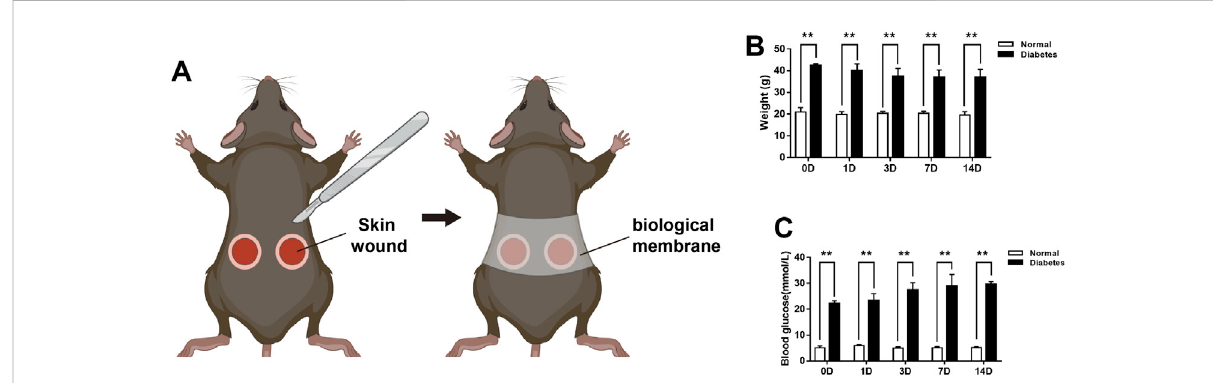
FIGURE 1 The experimental mice model and body weights and blood glucose levels of mice during wound healing (A) The wound healing model. Measurement of the mice body weights (B) and blood glucose levels (C) at days 0, 1, 3, 7, and 14 post-wounding. Data are presented as mean ± SD, ** p < .01, n = 6/group, two-way ANOVA, Bonferroni ’ s post hoc